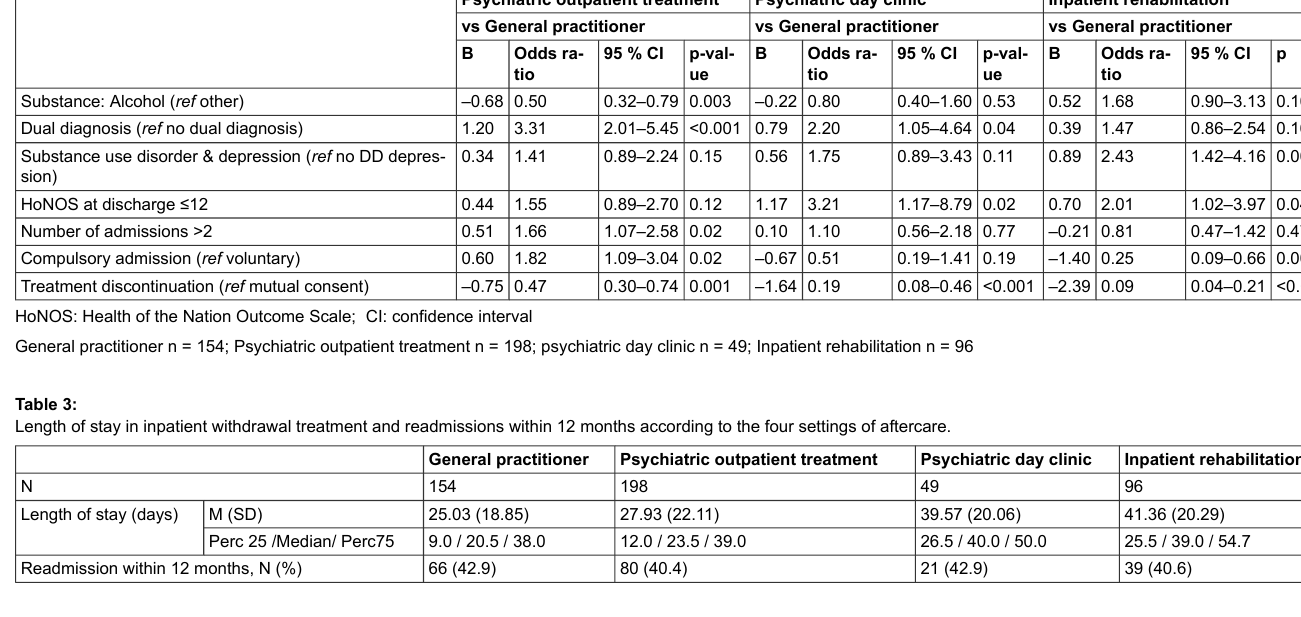
Table 2: Predictors of referral to a particular type of aftercare following inpatient withdrawal treatment.